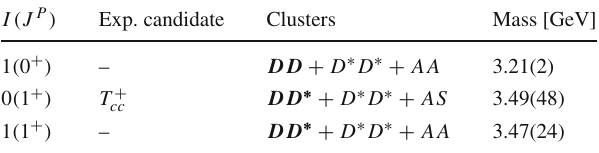
Table 2 Ground state masses for open-charm four-quark states. The errors stem from extrapolations of the eigenvalue curve on the real axis. Bold-written clusters denote the dominant component in the equation. A and S stand for axialvector and scalar